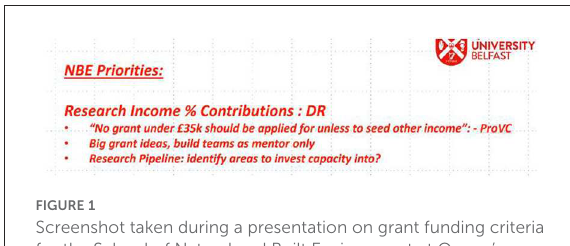
FIGURE1 Screenshot taken during a presentation on grant funding criteria for the School of Natural and Built Environment at Queen’s University Belfast